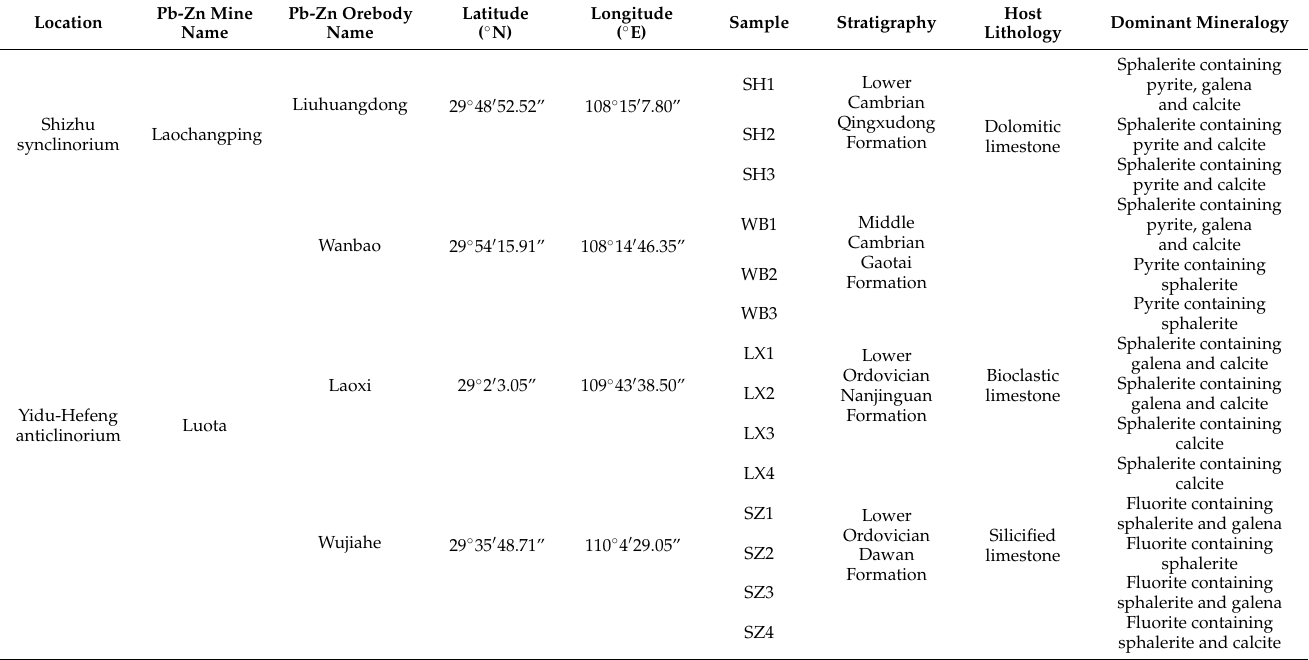
Table 1. Details of samples selected from the Laochangping and Luota Pb-Zn